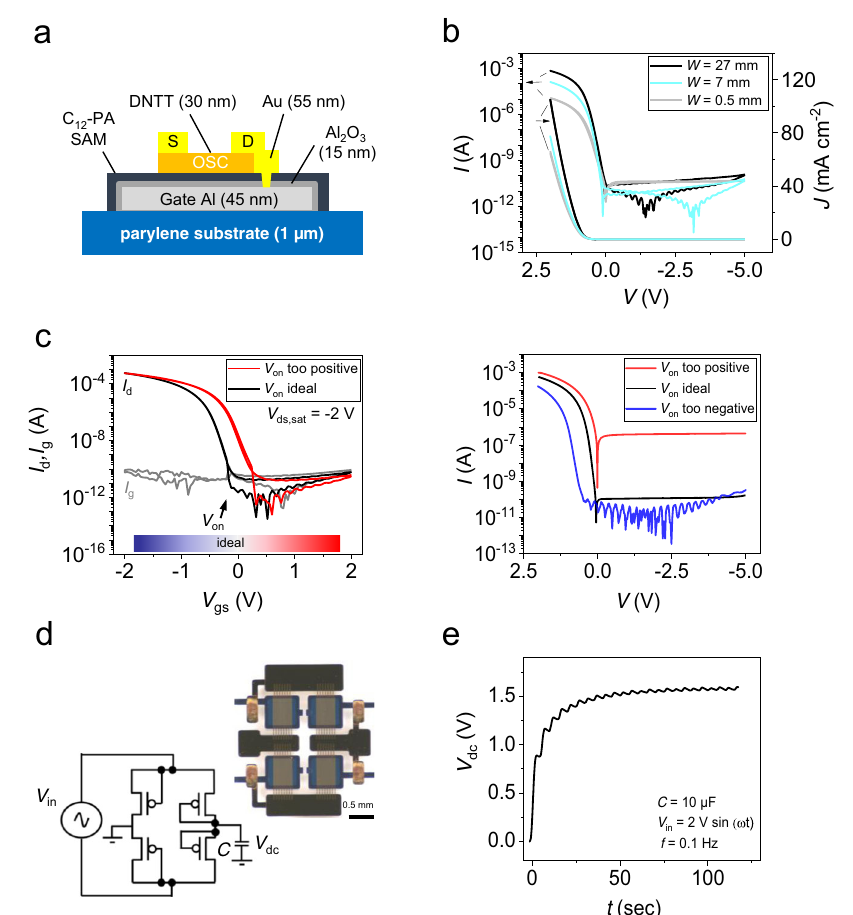
Fig. 6 Ultra fl exible organic recti fi er circuit. a Scheme of the organic recti fi er diode created with an OTFT by shortening the drain and gate contacts (C 12 - PA = 12-dodecylphosphonic acid, OSC = organic semiconductor, S = source and D = drain). b Representative I / V ( J / V ) curves of the organic diode for different channel widths W (channel length L fi xed to 12 µ m) fabricated on 1- µ m thin parylene. J is the current density. c The electrical transfer characteristics of the OTFT (left plot) are related to its performance when used as a diode (right plot) by shortening the drain-gate contacts. The characteristics in the left plot correspond to the black and red graph ( ‘ V on ideal ’ and ‘ V on too positive ’ ) in the right plot (see main text). d Photograph and equivalent circuit of an OTFT-based full-wave recti fi er circuit (OFWR) with W / L = 7000 µ m/12 µ m fabricated on 1- µ m thin parylene. e Recti fi ed output signal from an OFWR fed by an AC input signal V in (2 V sin (2 π f ∙ t ), f = 0.1 Hz) and connected to a capacitor of C = 10 µ The power output parameters for the three different harvesting modes are listed in Table 1. For the manual bending (mode A) performed at ~2 Hz, an open-circuit voltage with a peak value of about V oc = 5.5 V and a current peak under short-circuit conditions of I sc ~0.9 μA were measured (see Supplementary Fig. 15a for the time plot). By varying the external resistance, the maximum volumetric output power density reached P out,max ~3.2 mW cm − 3 (corresponding to an areal power density of P out,max (Fig. 7b), which is among the highest values ever reported for PENGs 1,4 .